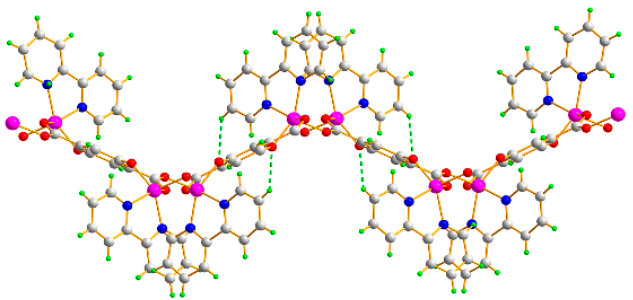
Figure 2. The hydrogen bonds (green dotted line).